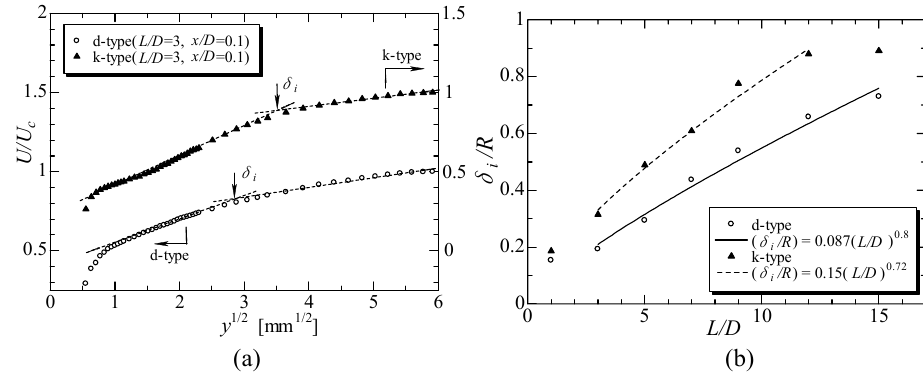
Fig. 12 Development of the internal boundary layer; (a) Mean velocity profile plotted as a function of (cid:1877) (cid:2869)/(cid:2870) ; (b) Development of internal boundary layer plotted as a function of roughness length